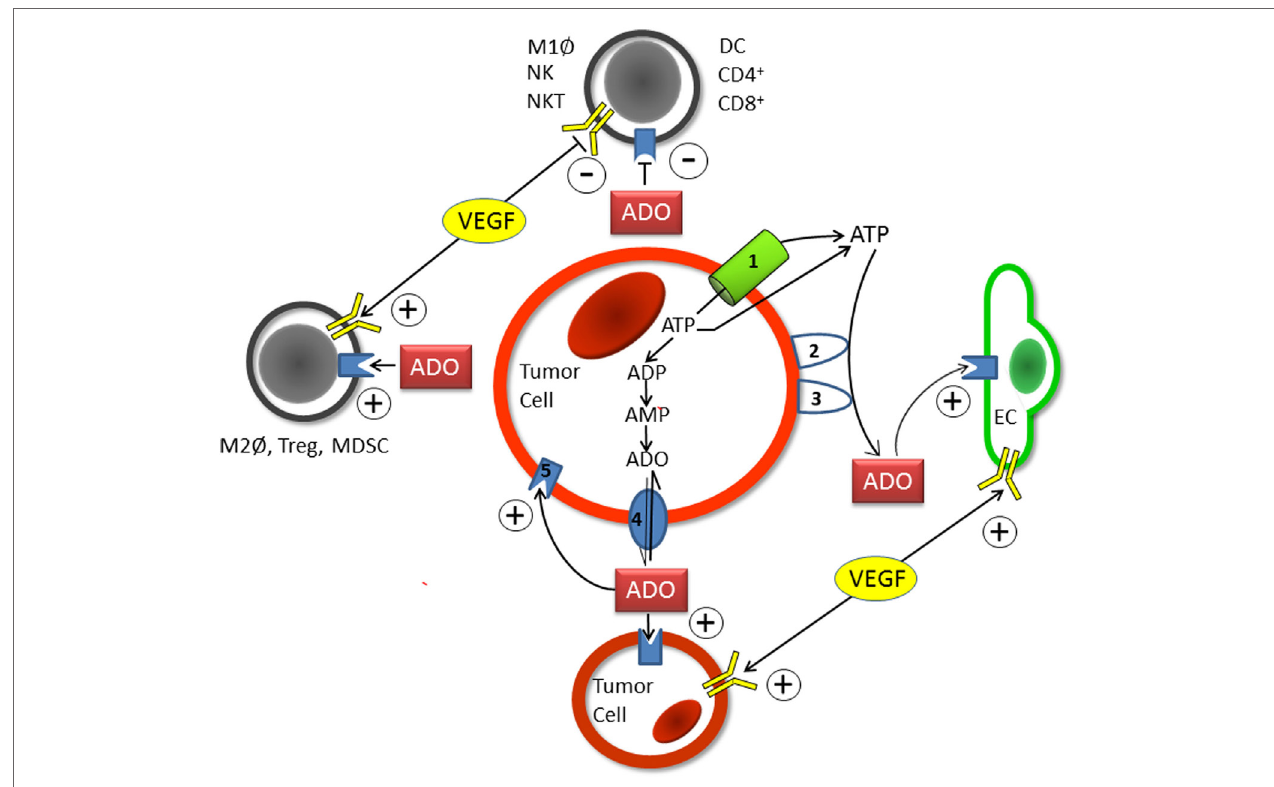
FIGUre 1 | Schematic diagram showing the individual steps of hypoxia-/HIF-1alpha-mediated adenosine (aDo) generation in the extracellular space (eCS) of tumor (and stromal) cells . Upon hypoxic stress, ATP (ATP 4 − ) is released into the positively charged ECS through pannexin-1 channels (1) or via exocytosis. Following the release of ATP into the ECS, the hypoxia-/HIF-1alpha dependent “tandem-enzymes” CD39 (2) and CD73 (3), the major nucleotide catabolizing enzymes, convert ATP into AMP and thereafter to ADO. Upon accumulation within the ECS and inhibition of ADO-uptake into the intracellular compartment by HIF-mediated inhibition of the nucleoside transporter ENT-1 (4), ADO acts in an autocrine and paracrine fashion in a sense that tumor-mediated immune suppression occurs (upper and left parts of Figure 1 ). Stimulating effects on endothelial (EC, right part of Figure 1 ) and tumor cells (lower part of Figure 1 ) are exerted through activation of A2A or A2B-receptors (5). Actions of VEGF/VEGFR expression on immune cells (and tumor and endothelial cells) are comparable to those elicited by ADO (see also Table S1A in Supplementary Material). Immune cells involved are specified in Table S1A in Supplementary Material. + , activation and stimulation; − , inhibition and